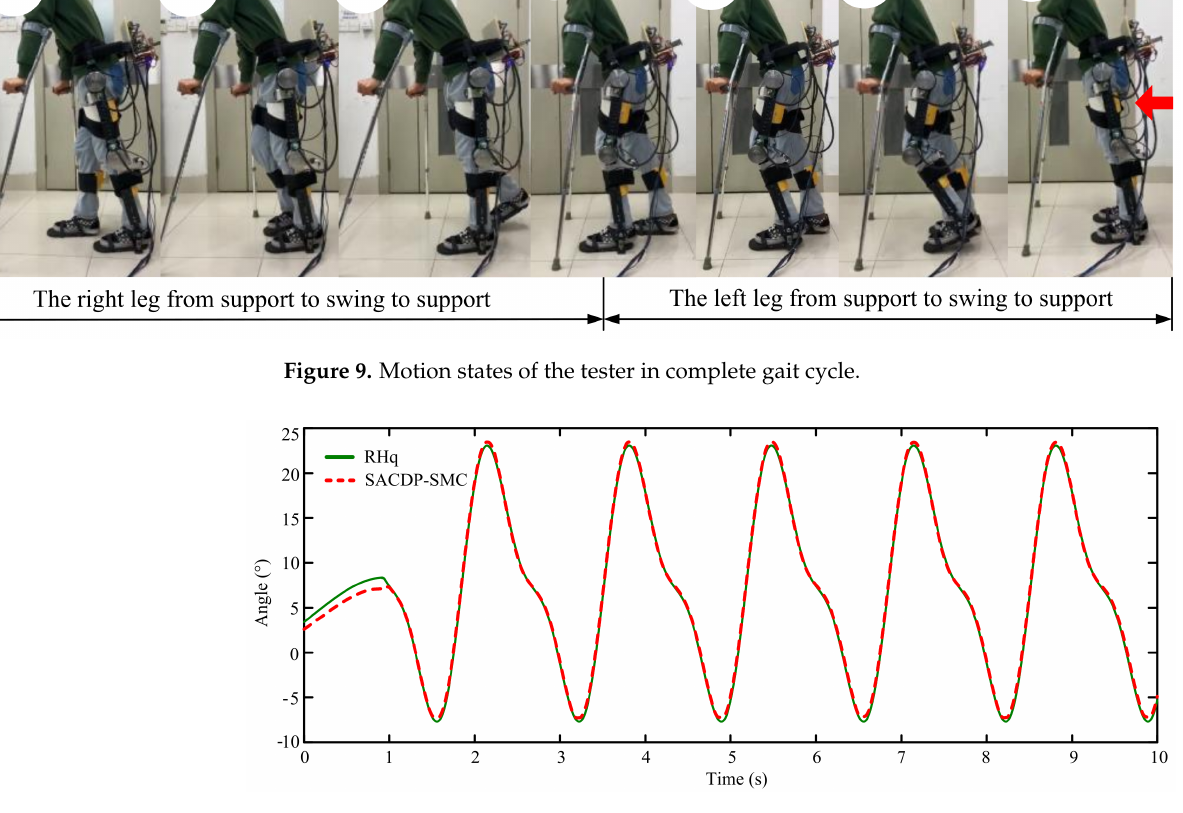
Figure 10. Trajectory tracking curve of the right hip